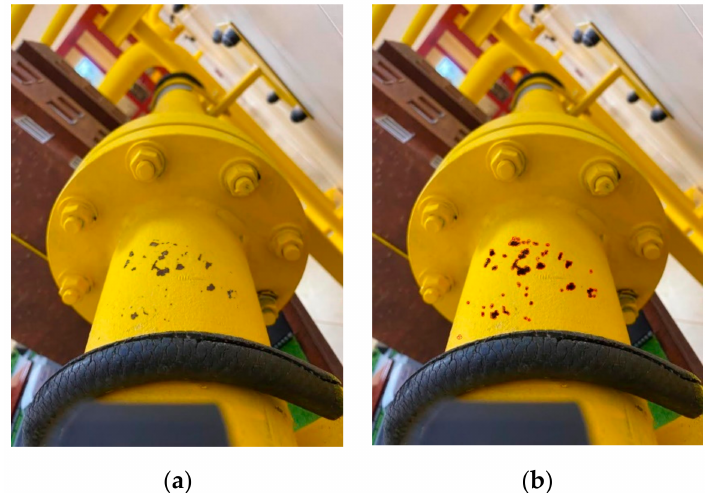
Figure 12. The result of data processing by the neural network on detection of complication signatures on the example of corrosion identification. ( a ) Original data before processing by the neural network; ( b ) data after processing in the mode of applying the red contour with shading of the silhouette of discovered objects. Copyrighted by authors.